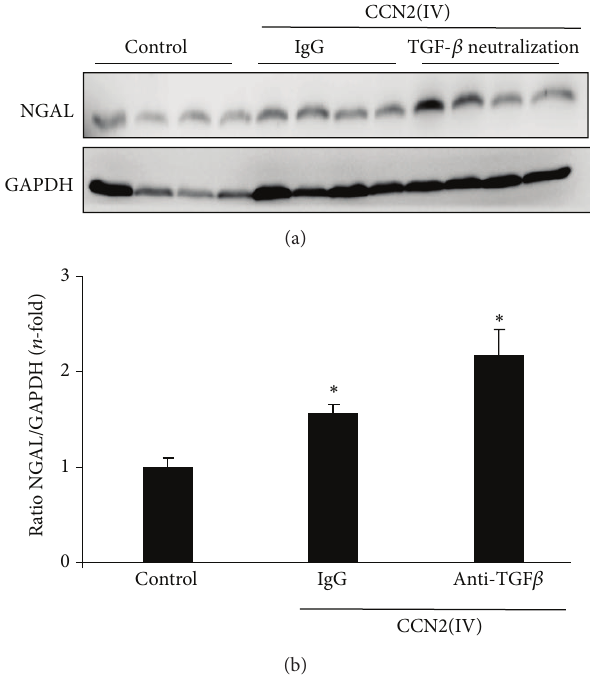
Figure 1: TGF- 𝛽 blockade exacerbates CCN2(IV)-induced renal damage. C57BL/6 mice received a single ip injection of 2.5 ng/g body weight recombinant CCN2(IV) or vehicle (saline) and were sacrificed after 10 days. For TGF- 𝛽 neutralization experiments, mice were treated with anti-TGF- 𝛽 antibody or an isotype IgG control ( 𝑛 = 10 mice per group) starting 24 hours before CCN2(IV) injection and every 72 h until sacrifice at day 10 after CCN2(IV). Renaldamagewasassessedbyevaluationofrenallevelsofbiomarker NGAL by western blot. (a) shows a representative western blot and data expressed as mean ± SEM ( 𝑛 = 10 animals per group) of fold- change as compared to controls. ∗ 𝑃 < 0.05 versus